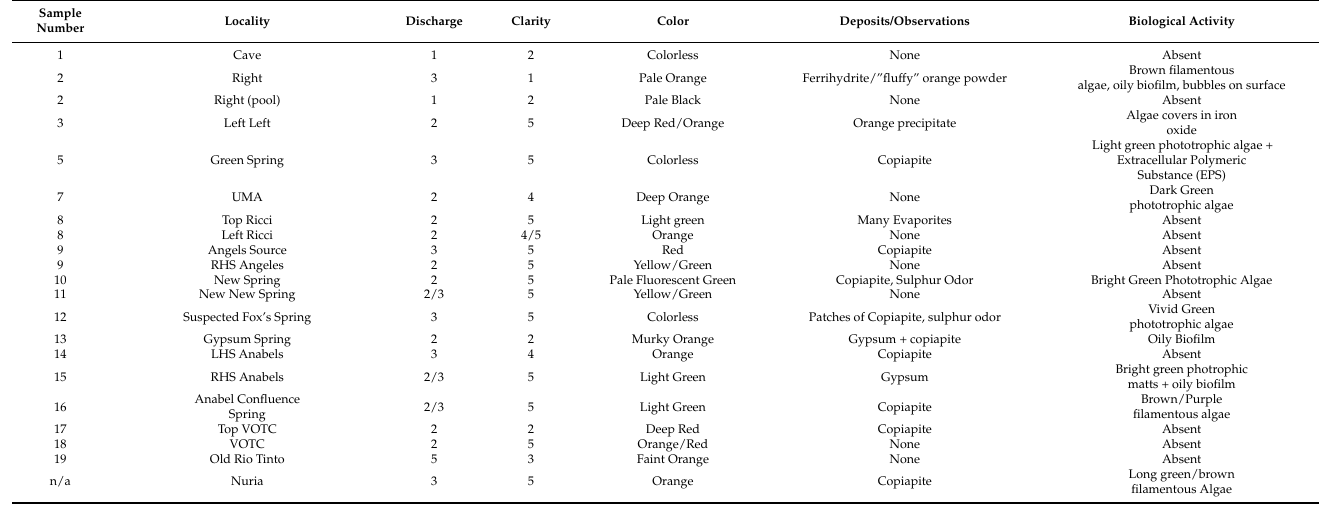
Table 1. Summary of the spring’s characteristics on a relative scale. Discharge: 1 = not visible; 2 = low; 3 = moderate; 4 = large; 5 = very large. Clarity: 1 = very poor; 2 = slightly cloudy; 3 = moderate; 4 = clear; 5 = excellent clarity. All scales used are on a relative scale